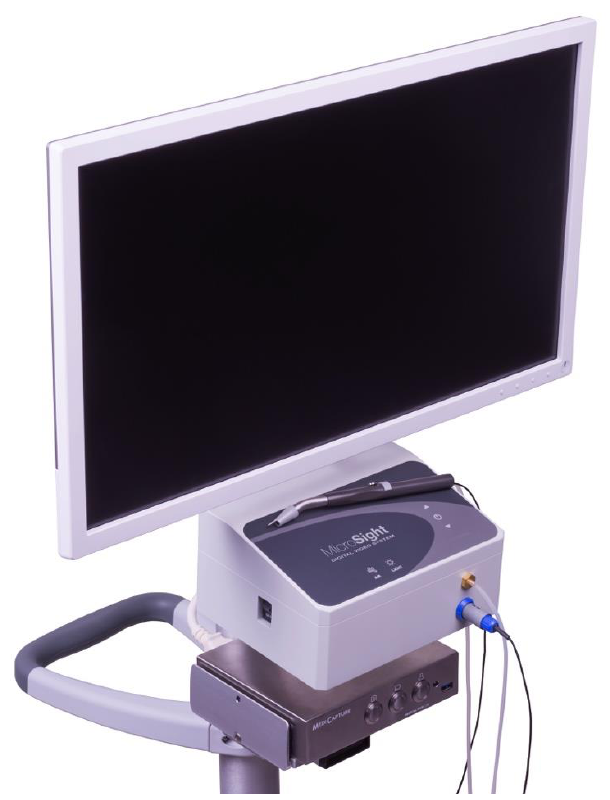
Figure 1. The videoscope designed for oral surgical procedures (MicroSight, Q-Optics,